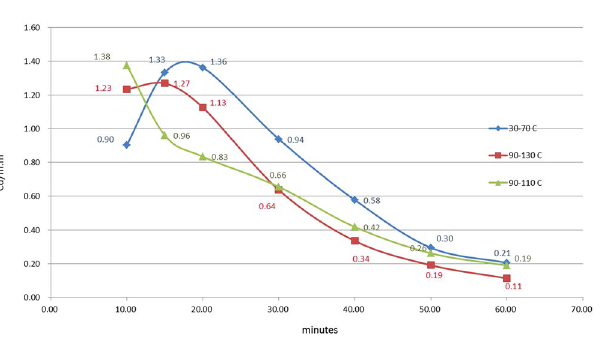
Figure 7. TL-time plot showing a decrease in luminescent intensity with an increase in temperature. The two cross curves are a part of Figs 5 and 6 respectively. The triangle symbol curve is from a test that began at 90 °C with a temperature increase to 110 °C 10 minutes